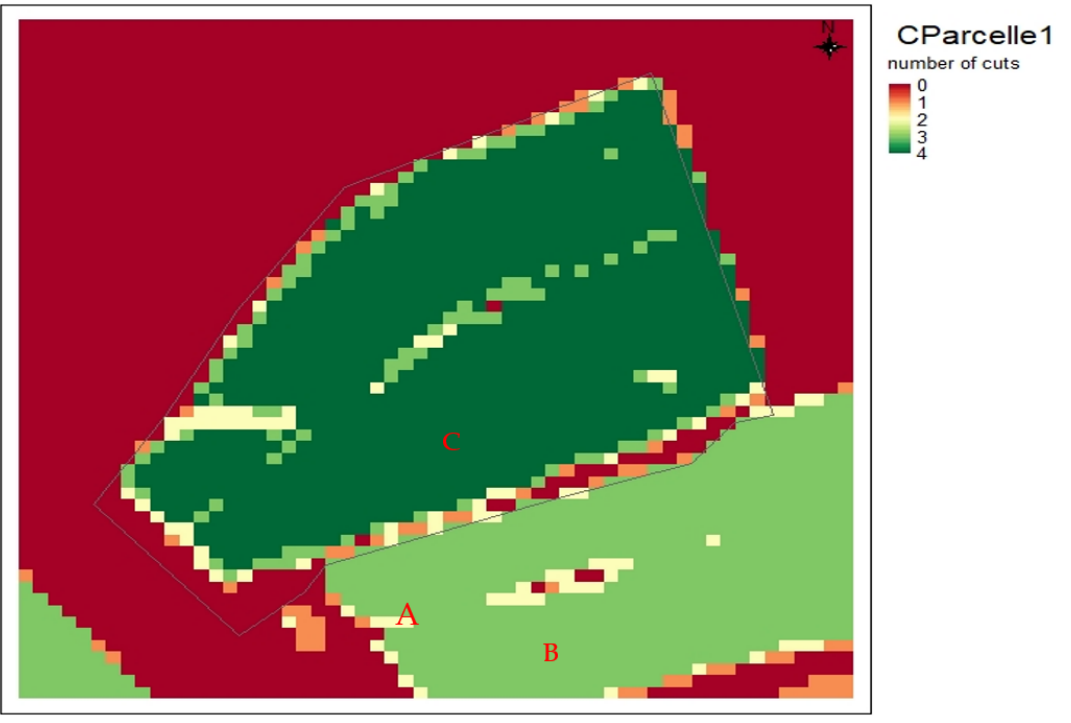
Figure 8. Results obtained after the second phase of calibration in 2019 showing locations of Figures 6, 9 and 10.